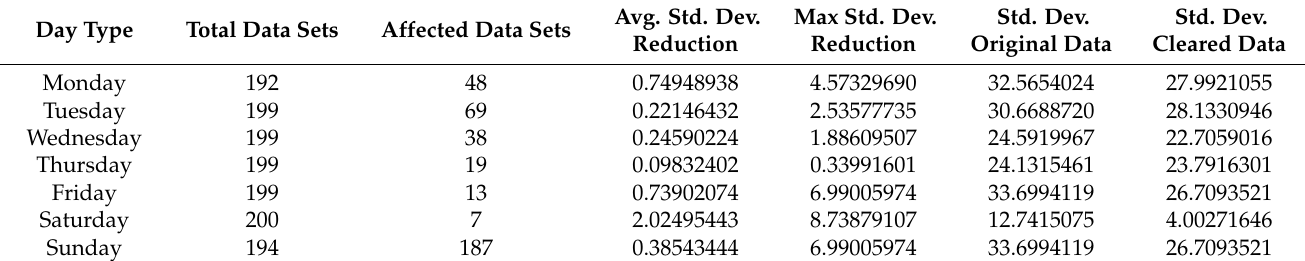
Table 8. Rest of the year baseline for original and cleared data.